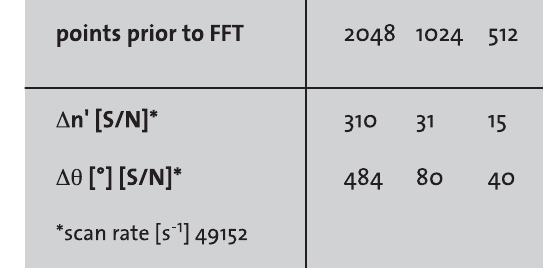
Figure 1: Schematic of the rheo-optic setup, including optical train and data analysis in the attached PC. The PC con- ducts the background cor- rection and calculates the birefringence D n’ the dichroism and D n’’ and the orientation angle q . Table 1: Change of signal to noise ratio by increasing the num- ber of points prior to the FFT (see figure 2). Birefringence data of PS-solution in DOP at 20°C. The applied shear rate was g · = 0.2s -1